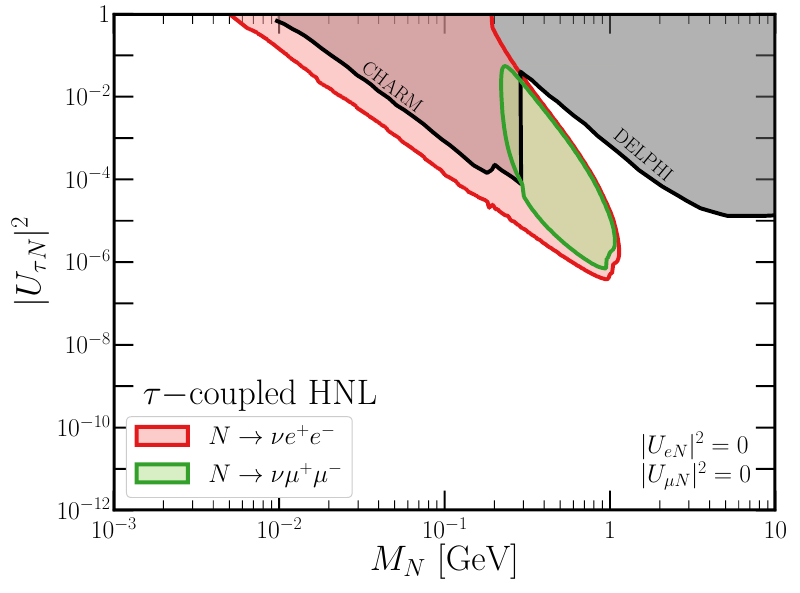
Figure 26 . Expected sensitivity of the DUNE MPD to a (cid:28) -coupled heavy neutral lepton, assum- ing ten years of data collection (how this time is apportioned between neutrino and antineutrino modes is irrelevant). We assume that the HNL is a Dirac fermion. We show sensitivity to the channels N=N (cid:23)e + e (cid:0) (red) and N=N (cid:23)(cid:22) + (cid:22) (cid:0) (green), compared against existing limits from ! ! CHARM [141] and DELPHI [133]. For the (cid:12)nal state (cid:23)e + e (cid:0) , the red region encompasses parameter space for which ten signal events are expected, whereas for the (cid:12)nal state (cid:23)(cid:22) + (cid:22) (cid:0) , the green region indicates twenty signal events, due to background considerations. See text for more